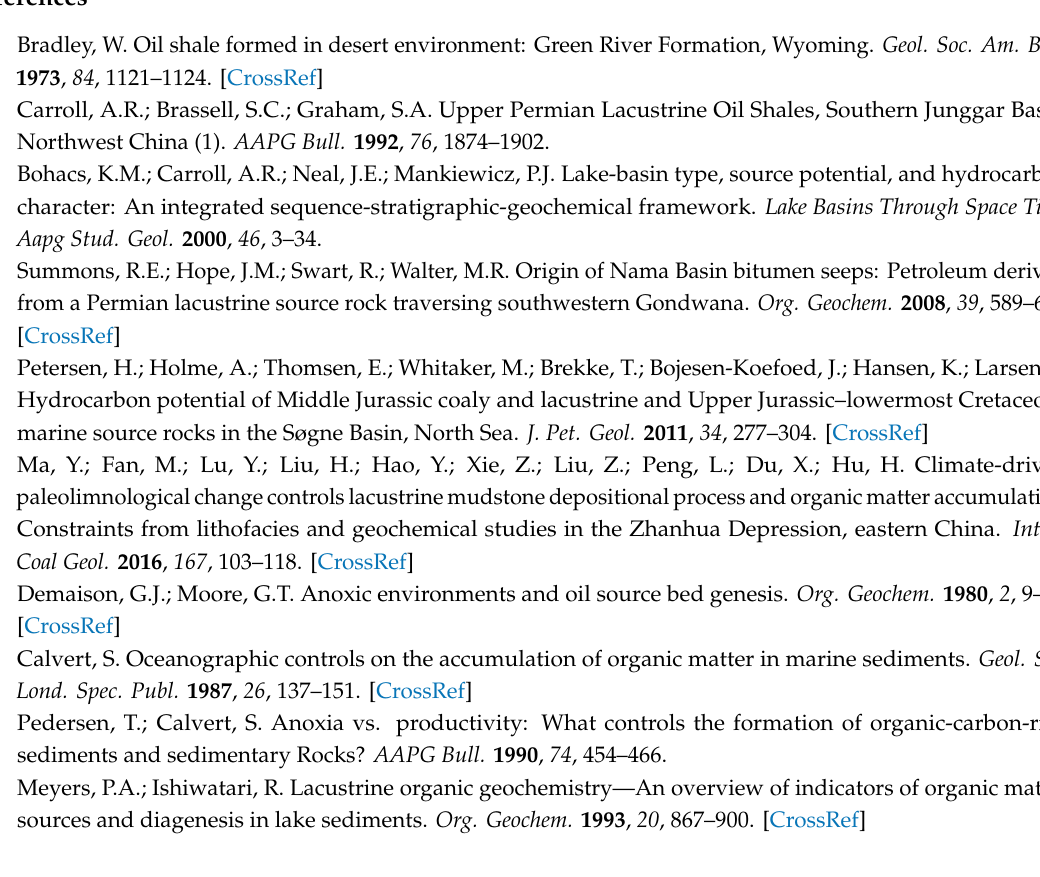
Table S1: The parameters of molecular markers of crude oil samples; and Table S2: Elemental geochemistry experiment data of source